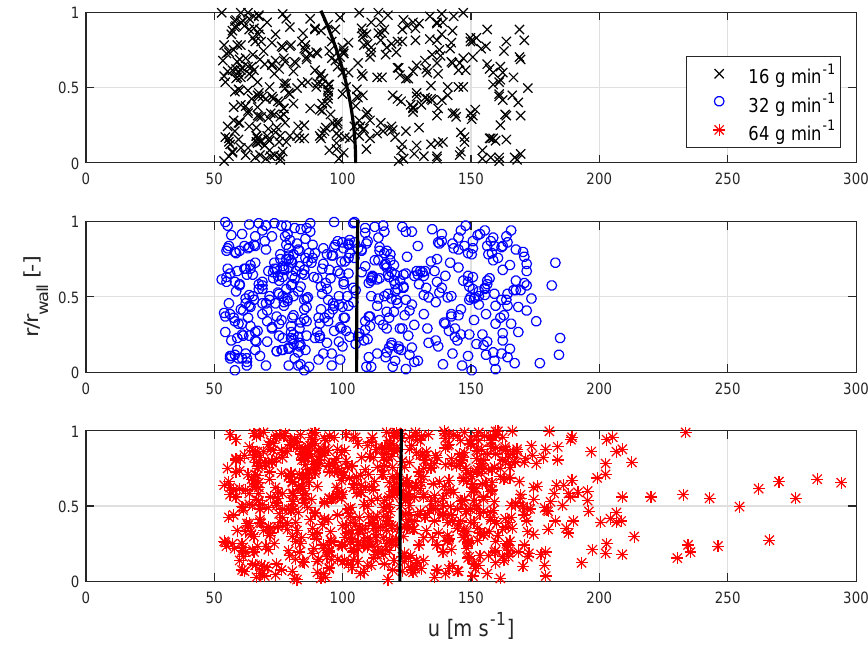
Figure 12. Comparison of titanium particle velocity profiles along radial position at the nozzle throat (coupled)